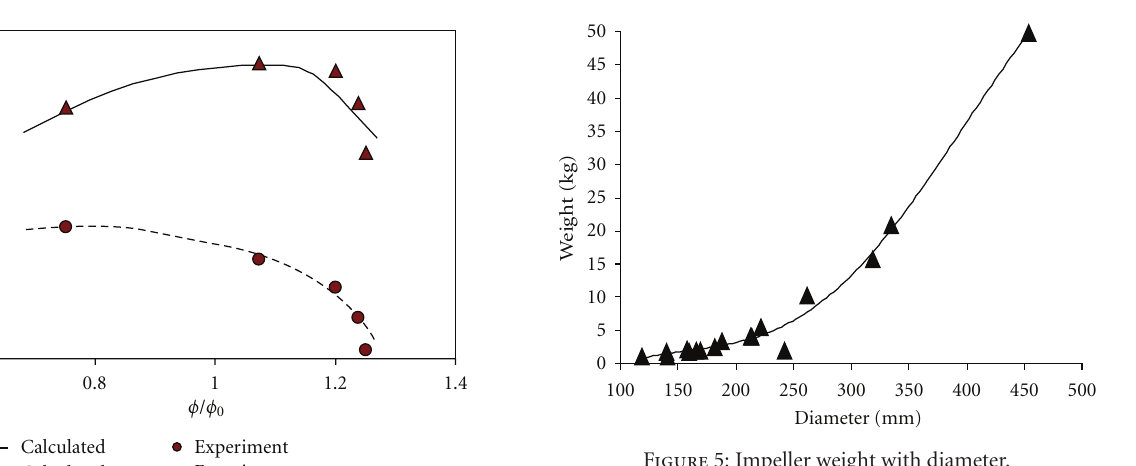
Figure 5: Impeller weight with